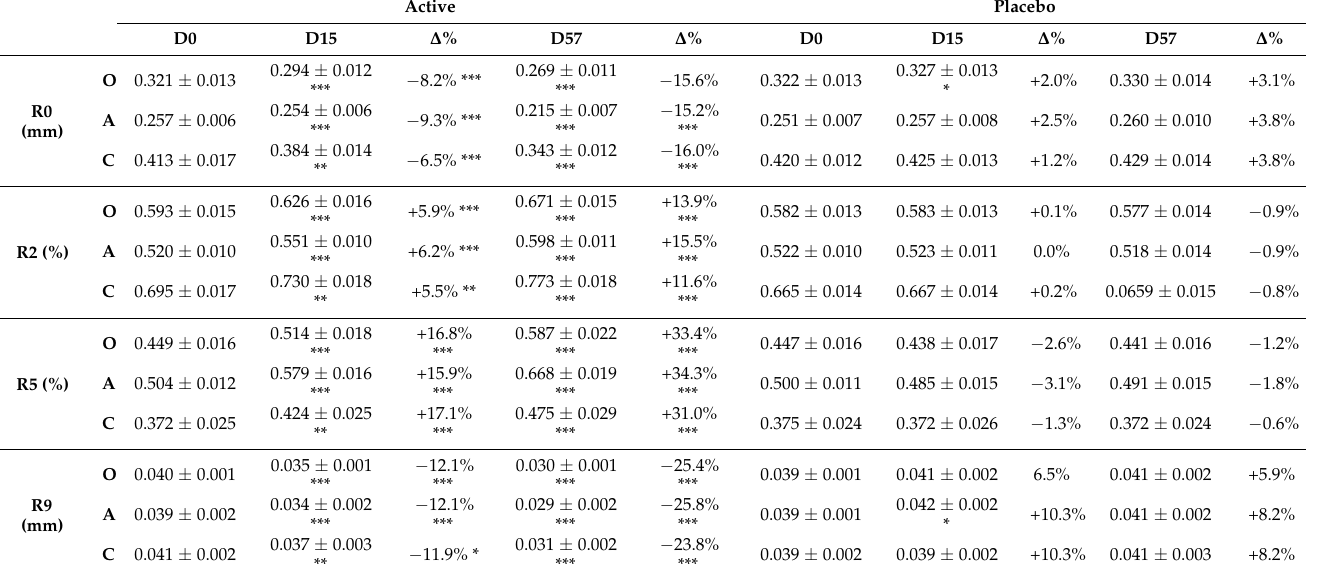
Table 3. Skin elasticity results. The intragroup (vs. baseline) statistical analysis is reported near the raw data, while the intergroup (active vs. placebo) statistical analysis is reported near the % variation ( ∆ %). The statistical analysis is reported as follows: * p < 0.05, ** p < 0.01, and *** p < 0.005.